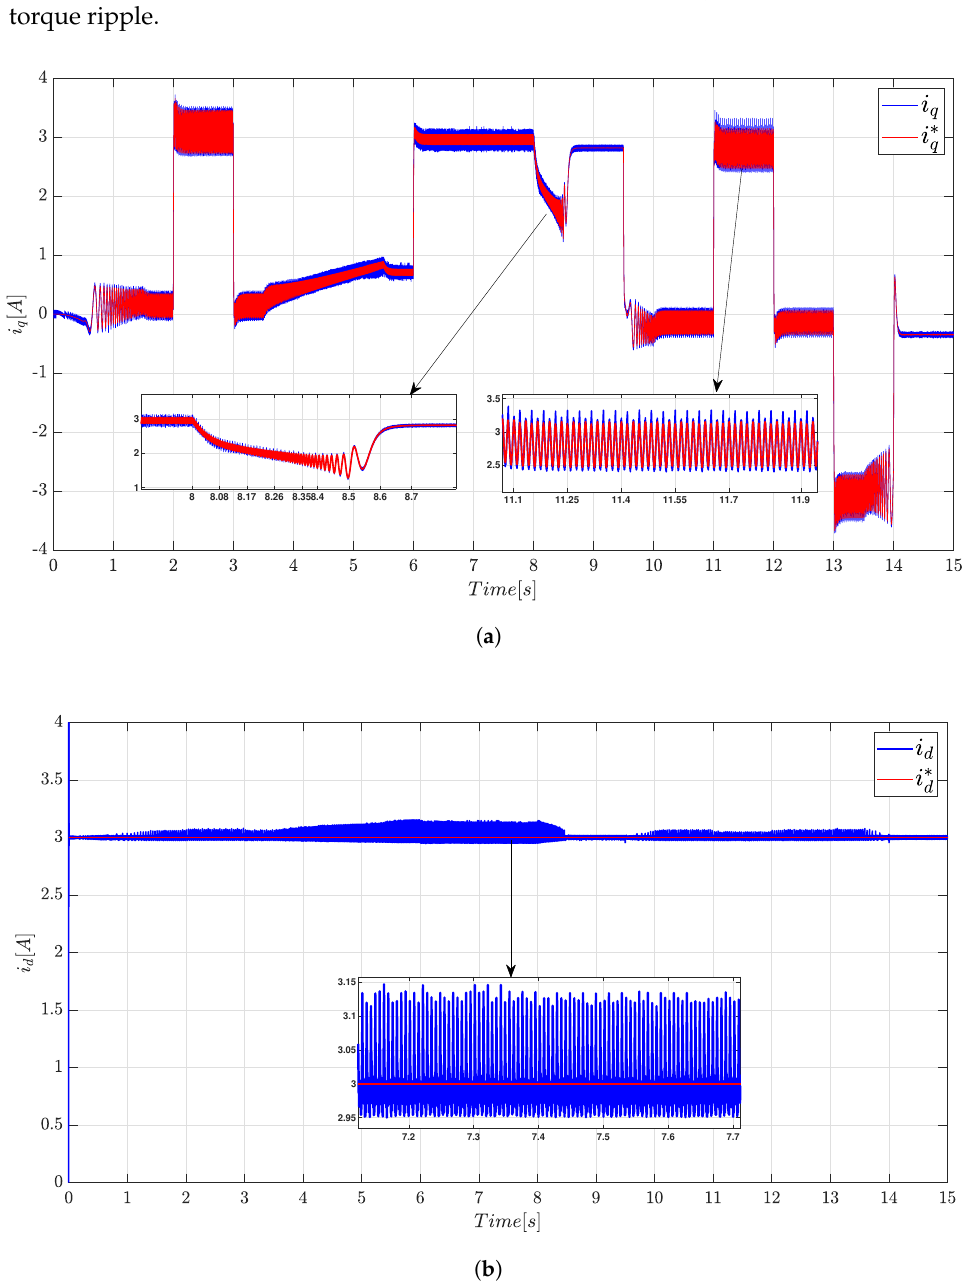
Figure 7. Response of the current components obtained by the PI controllers and the conventional field-oriented control: ( a ) i q response and ( b ) i d